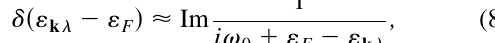
and BaPbO . 3 3 (its value is q;(cid:5) 3